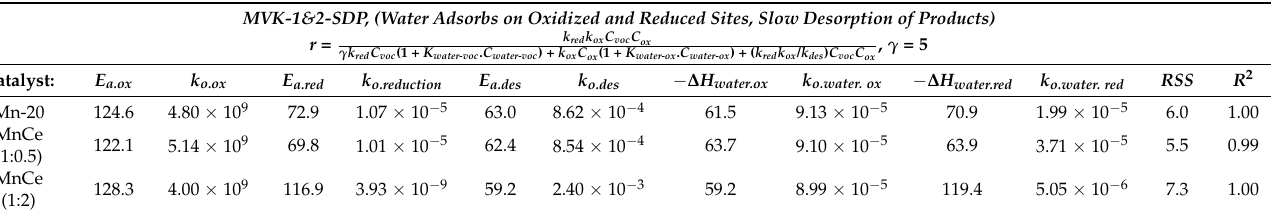
Table 8. Reaction rate expressions and kinetics parameters for applied MVK